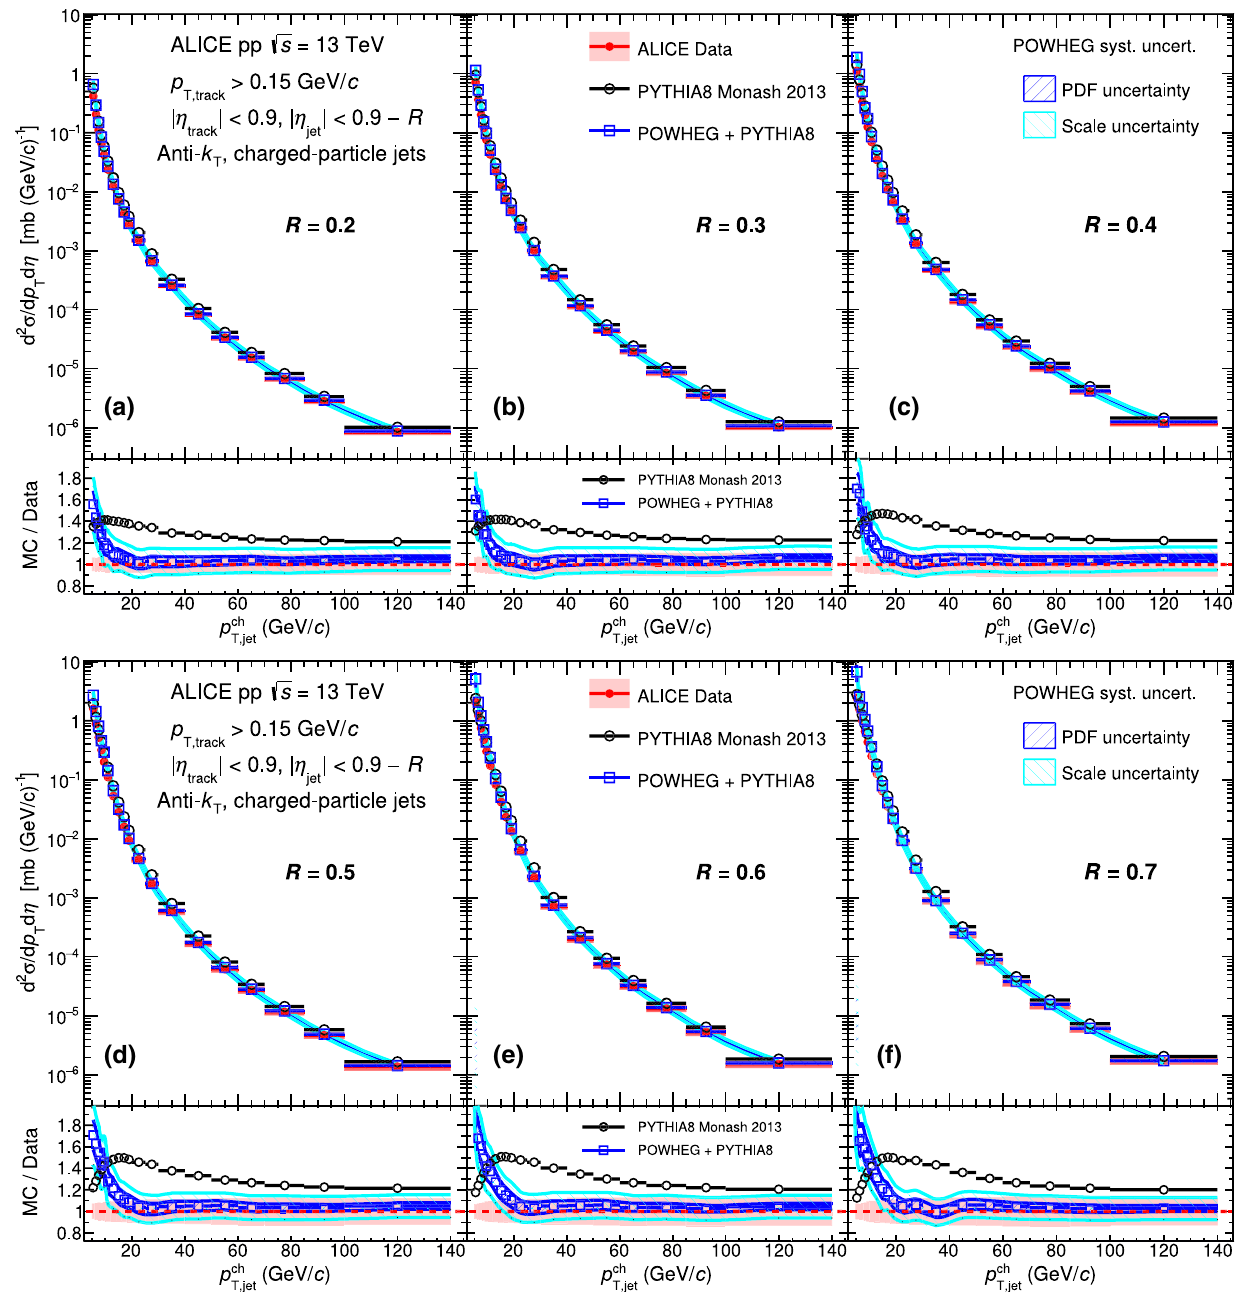
Fig. 16 Inclusive charged-particle jet cross sections in pp collisions at √ s = 13 TeV without UE subtraction and compared to LO and NLO MC predictions with different resolution parameters R varied from 0 . 2 to 0 . 7. The statistical uncertainties are displayed as vertical error bars.